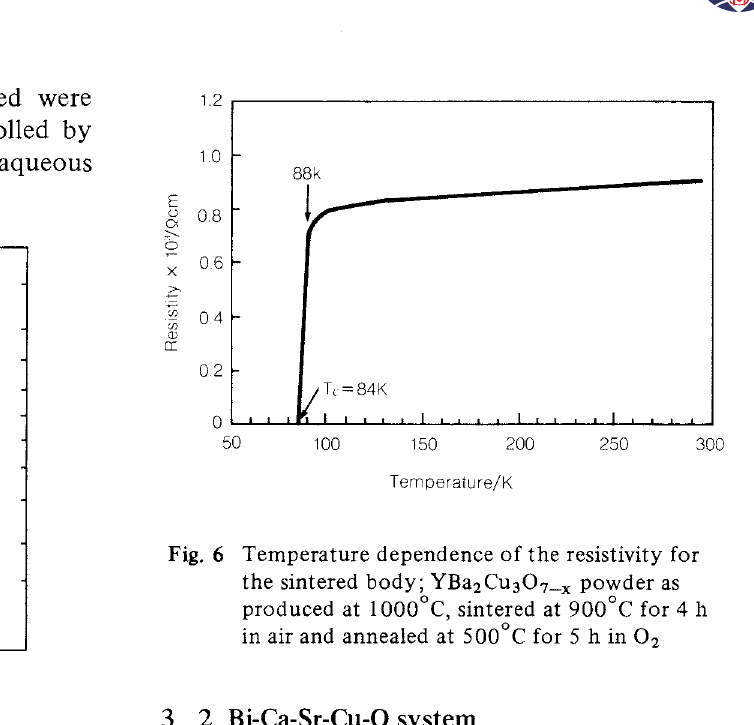
Fig. 6 Temperature dependence of the resistivity for the sintered body; YBa2Cu307-x powder as produced at 1000°C, sintered at 900°C for 4 h in air and annealed at 500°C for 5 h in 0